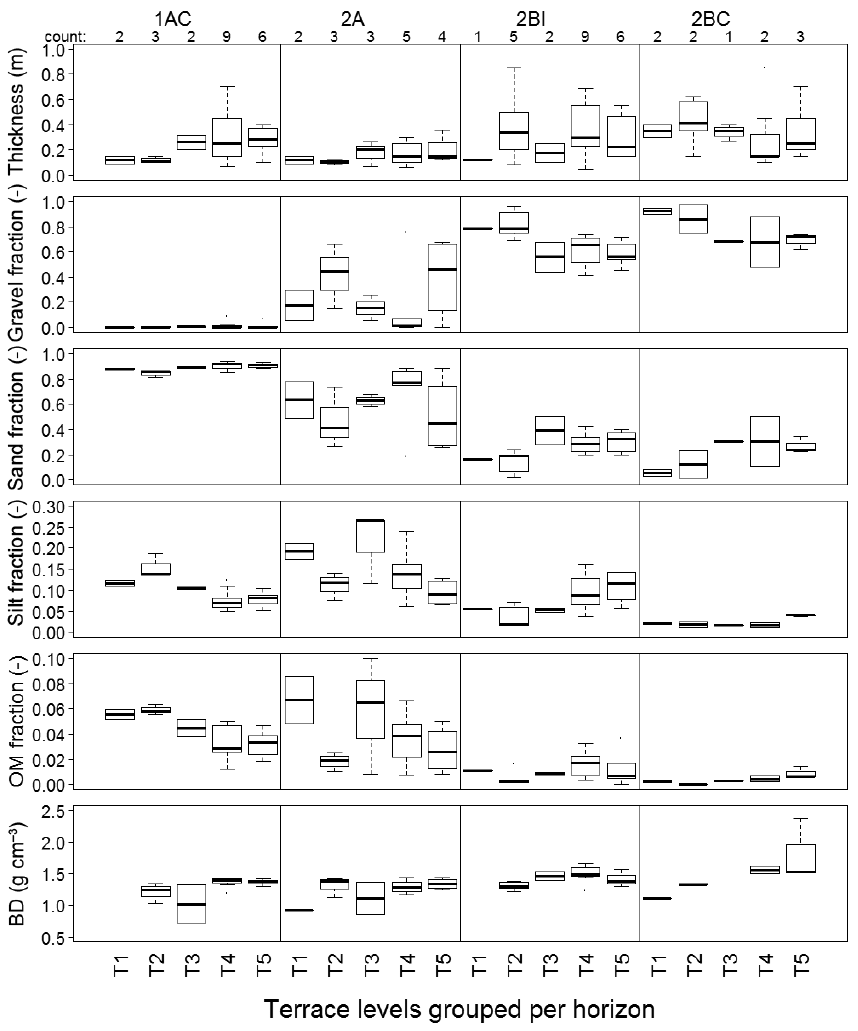
Figure 5. Box plots of observed soil properties on different terrace levels, ordered by main soil horizon. Counts indicate the occurrence of the displayed properties. Number of values can differ per soil property due to measurement